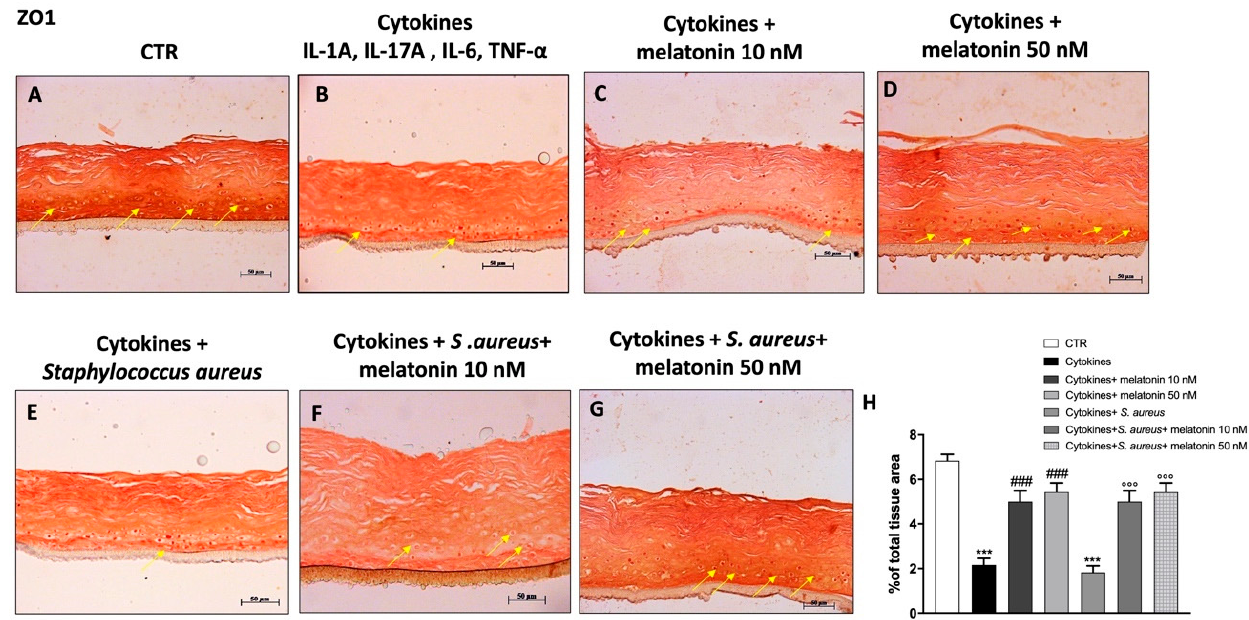
Figure 5. Effect of melatonin on ZO-1 expression. Immunohistochemical staining revealed that the cytokines and S. aureus group were characterized by a progressive decrease of ZO-1 expression compared to the control ( A , B , E ). The treatment with melatonin 10 nM and 50 nM significantly restored its expression, almost to basal levels ( C , D , F , G ). The yellow arrows indicate the positive staining. Data are representative of at least three independent experiments. ( H ) *** p < 0.001 vs. CTR; ### p < 0.001 vs. cytokines group; ◦◦◦ p < 0.001 vs. cytokines+ S. aureus group.